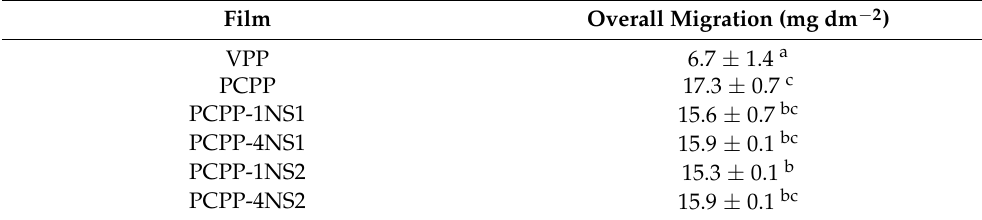
Table 4. Overall migration of VPP, PCPP and nanocomposite films to olive